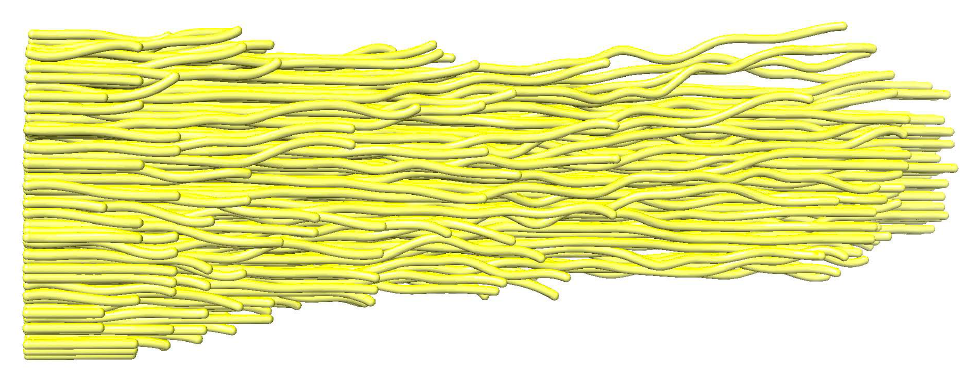
Figure 2. Manually traced filaments in the stereocilia taper region. The manual “spaghetti” model is consistent with the experimentally observed density of the actin filaments [18] in cryo-ET. The true position of actin filaments in the experimental map is not known with complete certainty, but manual tracing can serve as a ground truth for testing our algorithms when using simulated tomograms modeled after the shown filament traces. All molecular graphics figures in the present paper have been prepared with UCSF Chimera [23] and oriented with the + Y direction to the